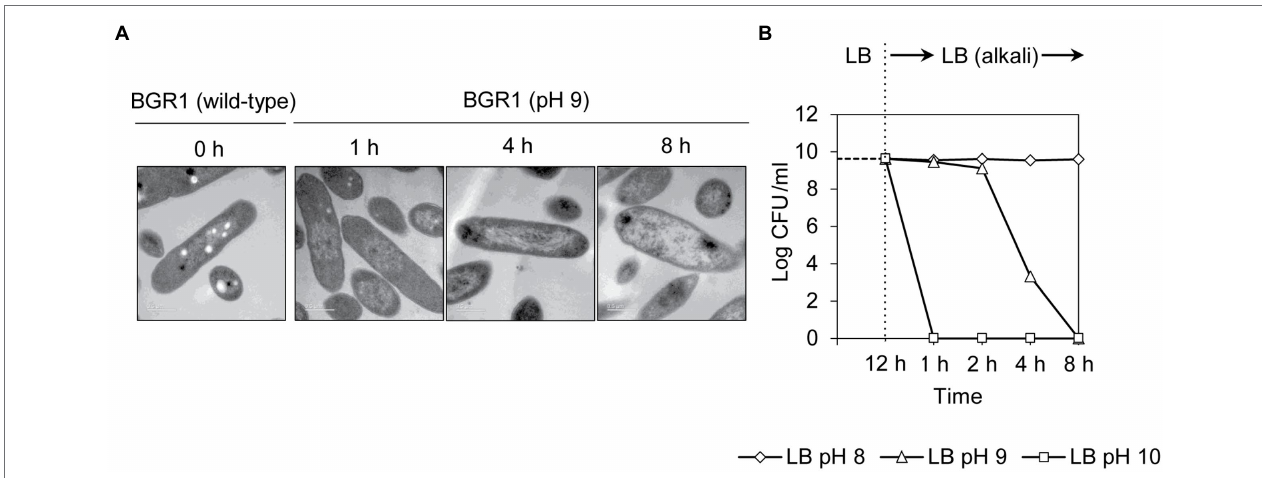
FIGURE 3 | Cell death in wild-type BGR1 induced by alkaline stress. (A) TEM images of wild-type BGR1 after exposure to pH 9 at different times. Scale bars, 0.5 μ m. (B) Cell viability of wild-type BGR1 following exposure to alkaline stress. Wild-type BGR1 was artificially challenged at pH 8, 9, or 10 to induce alkaline stress at 37 ° C. The cell population was determined based on the number of colony-forming units (CFUs) through plate-counting